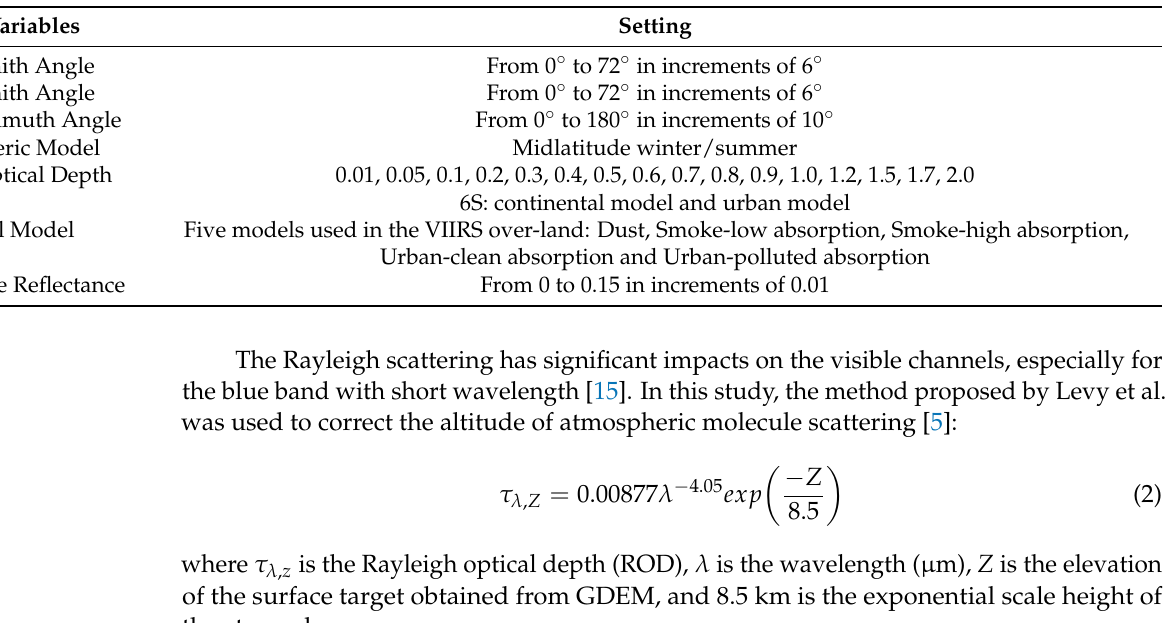
Table 3. Input variables for the calculation of the look-up table. Input Variables Setting